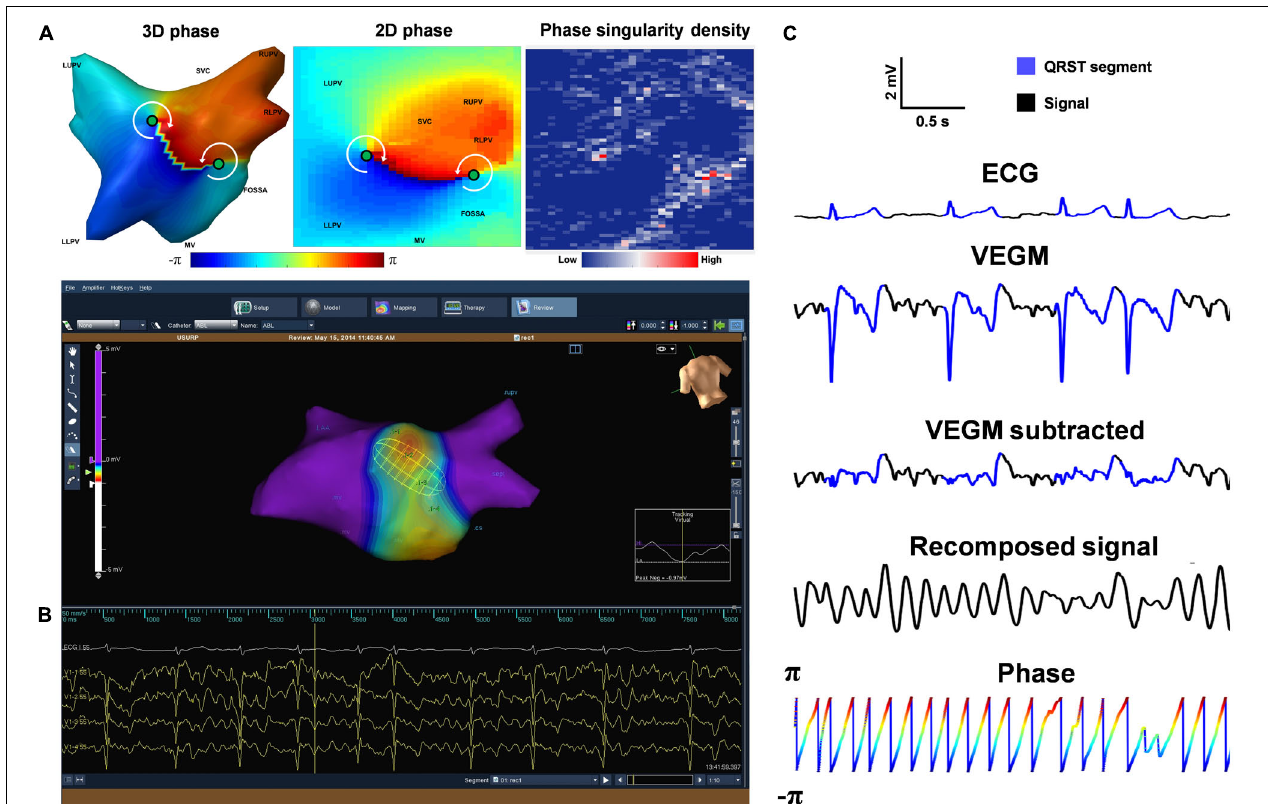
FIGURE 1 | Data acquisition and signal processing. (A) Reconstructed 3D left atrial geometry with color-coded phase map, its 2D representation (cylinder projection) showing PS points (green circles) and example of a 2D PSD map. (B) The screenshot of the Ensite Velocity mapping system showing a isopotential/voltage map with the non-contact Ensite Array catheter. (C) Example of ECG (Lead I), VEGM, QRST-subtracted VEGM, recomposed signal using sinusoidal wavelet reconstruction and Phase signal (color-coded by phase), with the QRST segments highlighted in blue. LUPV, Left Upper Pulmonary Vein; RUPV, Right Upper Pulmonary Vein; LLPV, Left Lower Pulmonary Vein; SVC, Superior vena cava; MV, Mitral